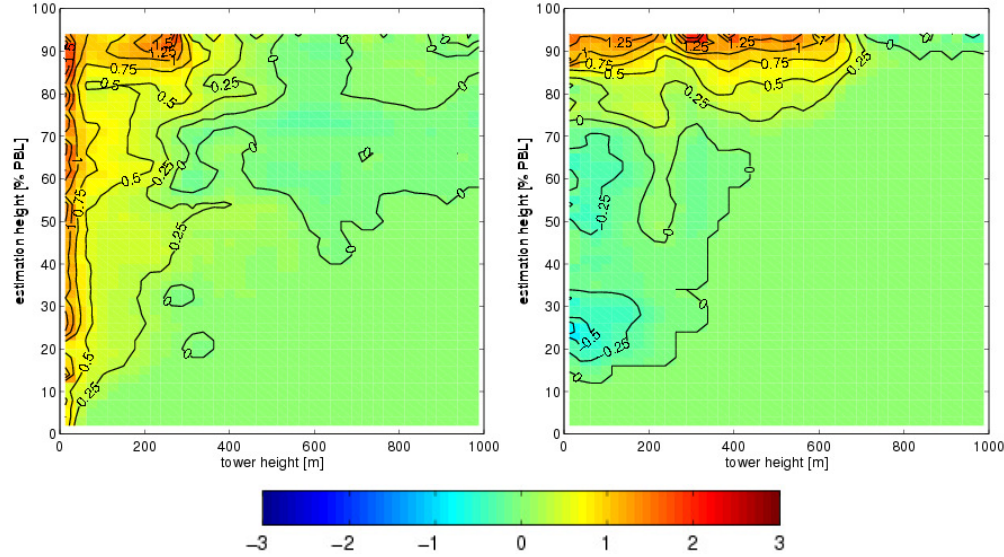
Figure 5. Difference of the median biases of the estimations applying and not applying the VTT concept (µmolmol − 1 ) as a function of the height of the hypothetical tower (tower height) simulated by the aircraft or the existing tower and the relative height within the PBL for which the mole fraction is extrapolated (estimation height) from the measurements at the top of the hypothetical tower. A positive sign indicates that the application of the VTT concept improves the estimation. Left: summer; right: